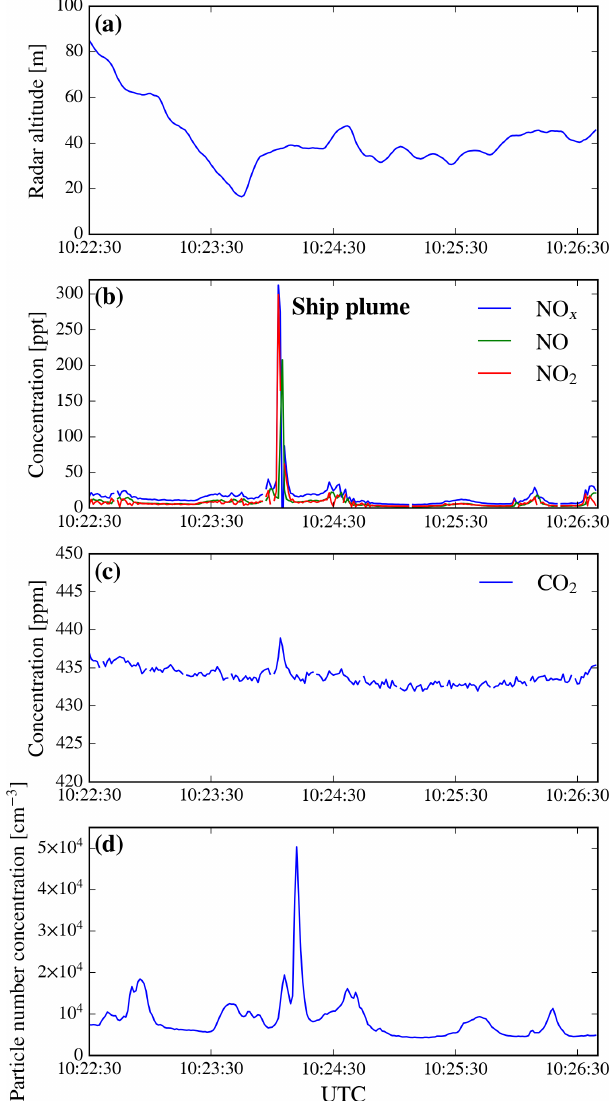
Figure 8. Time series of different variables measured above the sea during the C017 flight: (a) altitude; (b) NO, NO 2 and NO x concen- trations; (c) CO 2 concentration; and (d) total aerosol concentration. Only the times close to the large plume that could be correlated to a specific vessel are shown here. CO and O 3 concentrations (not shown) exhibited no enhancement. The plotted time period corre- sponds to the beginning of a level run at ∼ 40m altitude, the trajec- tory of which can be seen in Fig.